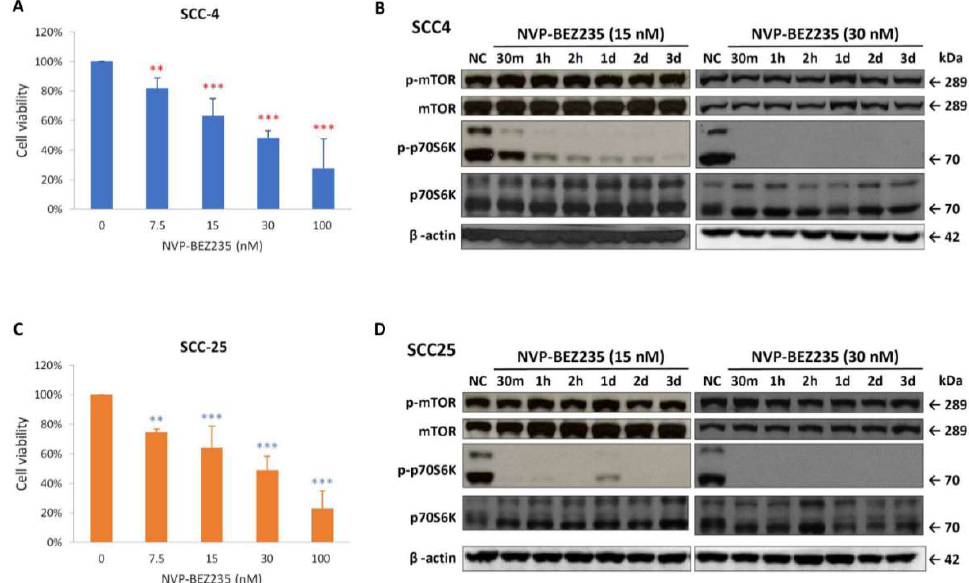
Figure 2. NVP-BEZ235 suppressed cell proliferation and reduced the expression of phospho-mTOR and phospho-p70S6K in SCC-4 and SCC-25 cells. The inhibitory effects of various doses (7.5, 15, 30, and 100 nM) of NVP-BEZ235 on SCC-4 ( A ) and SCC-25 ( C ) cells were assessed using MTT assay after 72 h of treatment. Data presented are the mean and standard error of the mean of three independent experiments. The ** p < 0.01 and *** p < 0.001 indicate the statistical significance of differences between the results for cells with and without treatment (red ** and *** for SCC-4 and blue ** and *** for SCC-25). As determined through Western blotting, NVP-BEZ235 reduced the expression of phospho-mTOR (p-mTOR) and phospho-p70S6K (p-p70S6K) in SCC-4 ( B ) and SCC-25 ( D ) cells. SCC-4 and SCC-25 cells were treated with 15 or 30 nM NVP-BEZ235 for 30 min (30 min), 1 h (1 h), 2 h (2 h), 1 day (1 d), 2 days (2 d), and 3 days (3 d) in six-well plates. Western blot analysis was performed to examine